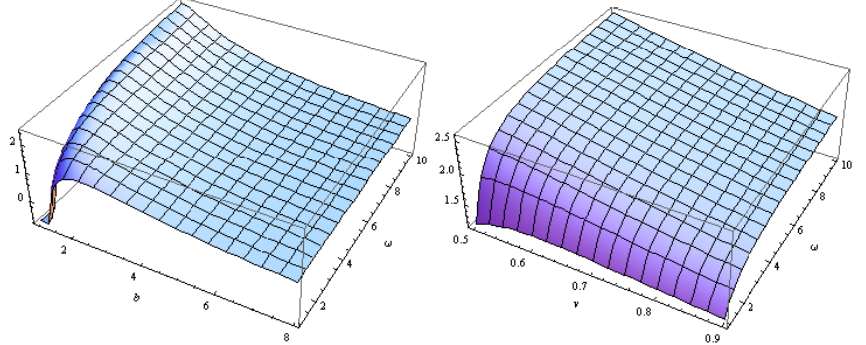
Figure 12. ( left ) The variation in total deflection 2 (cid:101) ( 0 ) at φ = 0 is shown with respect to b and ω . ( right ) Total deflection 2 (cid:101) ( 0 ) at φ = 0 is shown with respect to b and ω